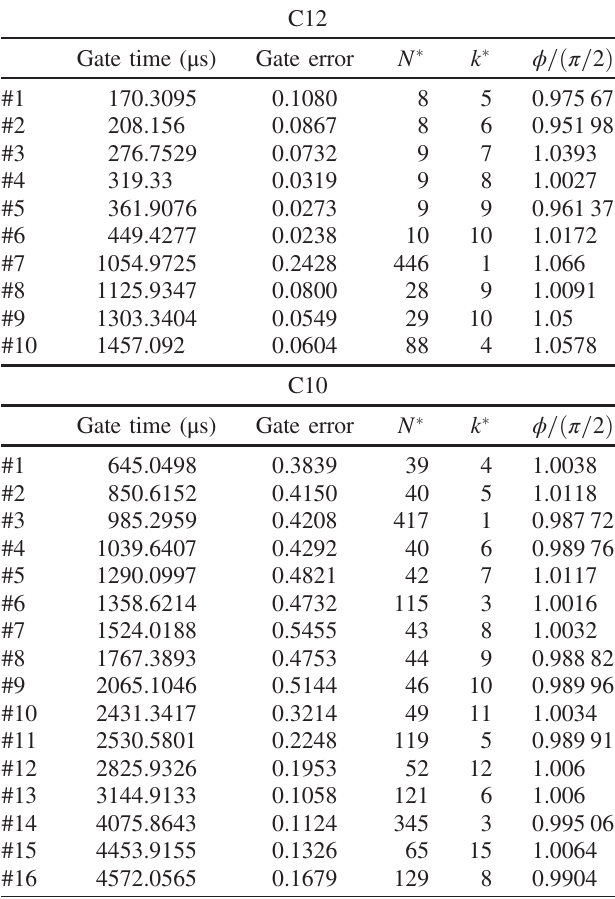
TABLE XII. Optimal iterations ( N (cid:3) ) and resonances ( k (cid:3) ) to π = 2 Þ between the electron and C12 or C10. We perform CR x ð provide a list of optimal cases for T ≤ 1 . 5 ms for C12. For C10, we cannot satisfy the bound of unwanted one-tangles for this time constraint, so we further list cases for T up to 5